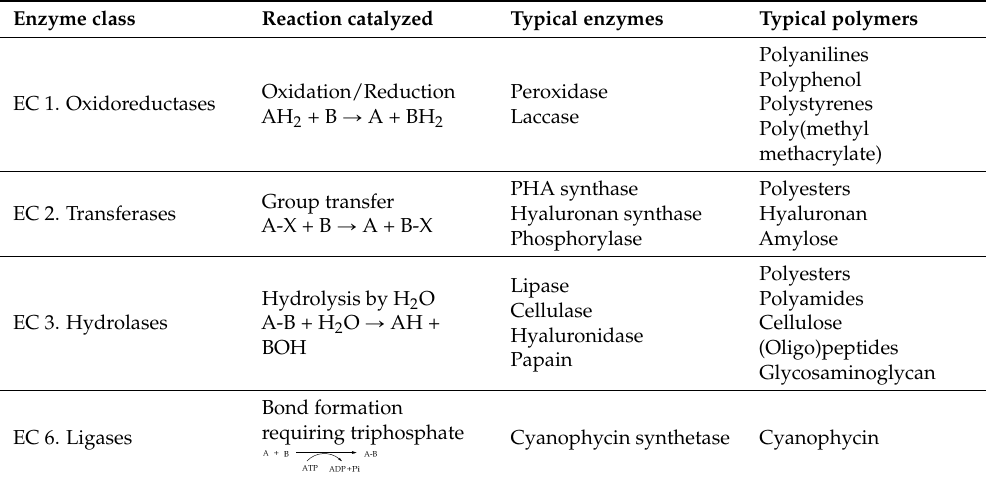
Table 3. Enzymes and typical examples for their use in polymer synthesis, and typical polymers synthesized via enzymatic polymerization